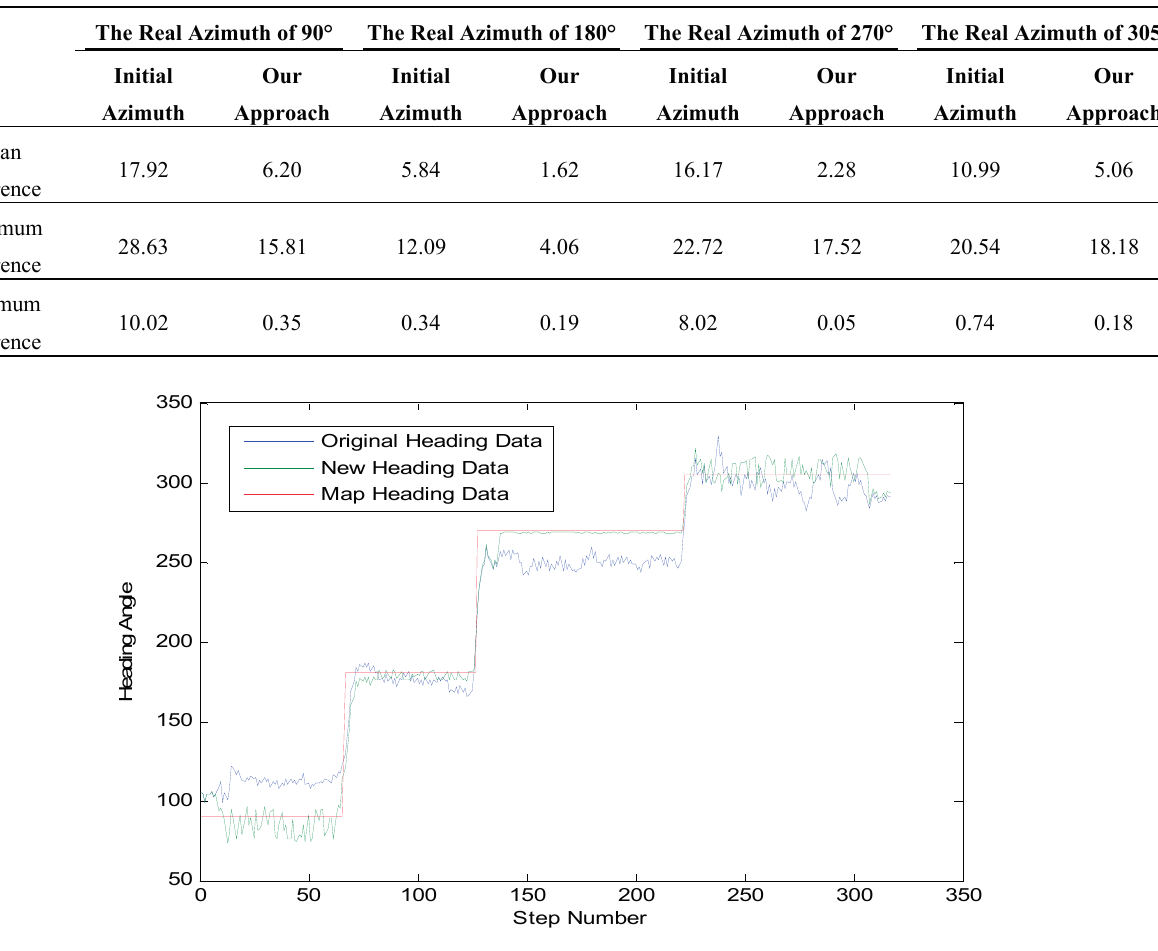
Figure 8. Test for heading